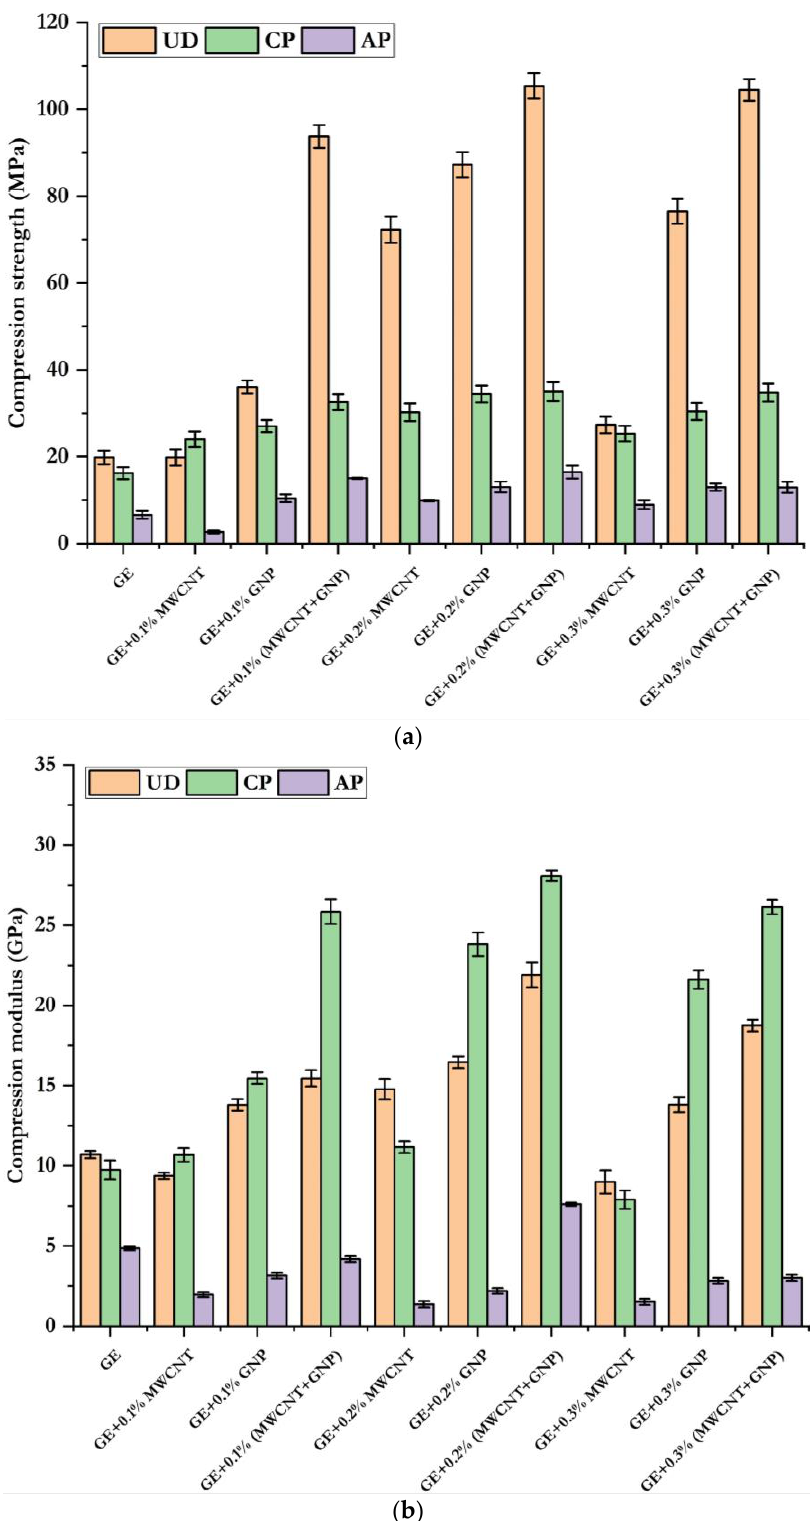
Figure 8. Compressive properties of GE composites: ( a ) compressive strength ( b ) compressive modulus. The compressive failure in tested samples is shown in Figure 9 at 20 ×